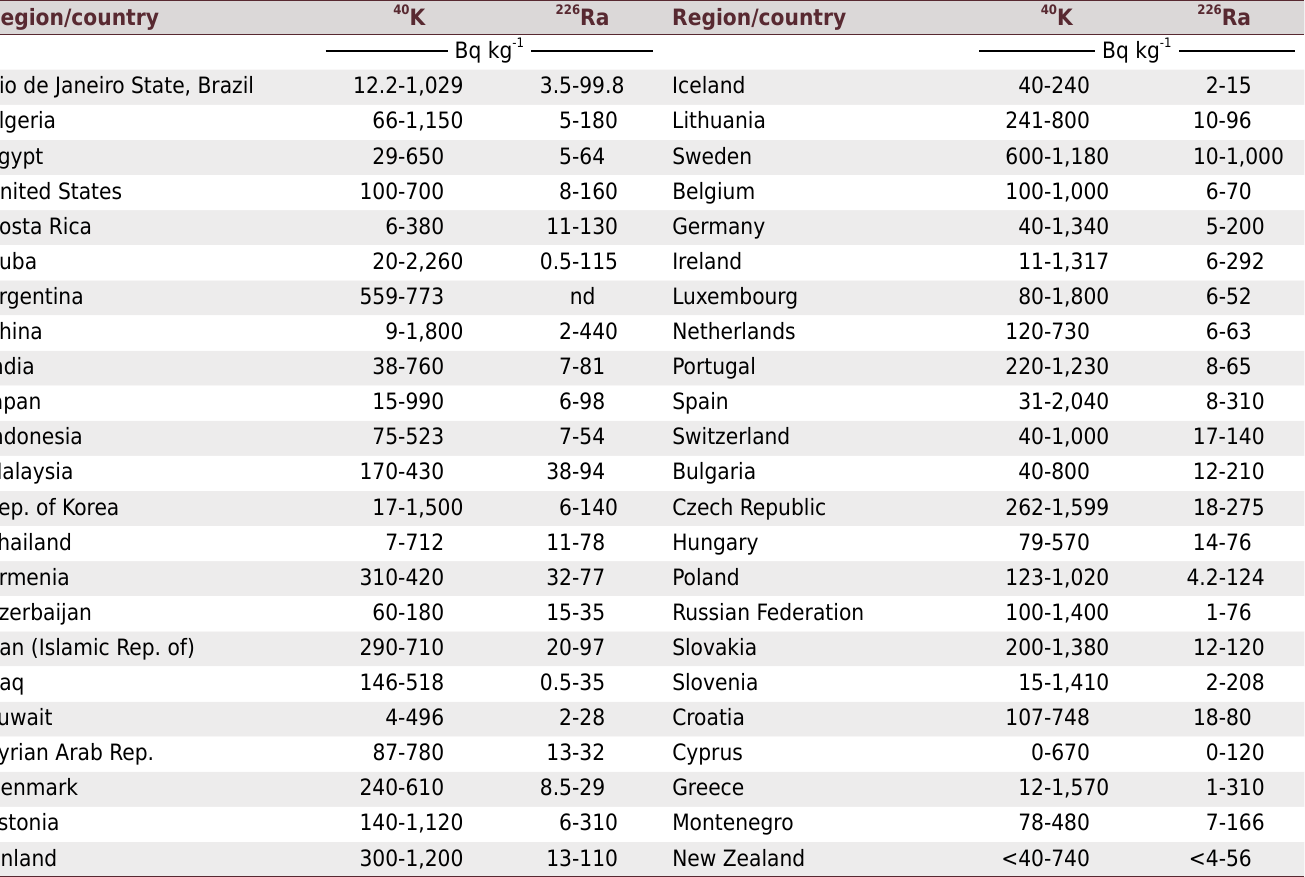
Table 5. Ranges of 40 K and 226 Ra in soils worldwide [adapted from Unscear (2008)]